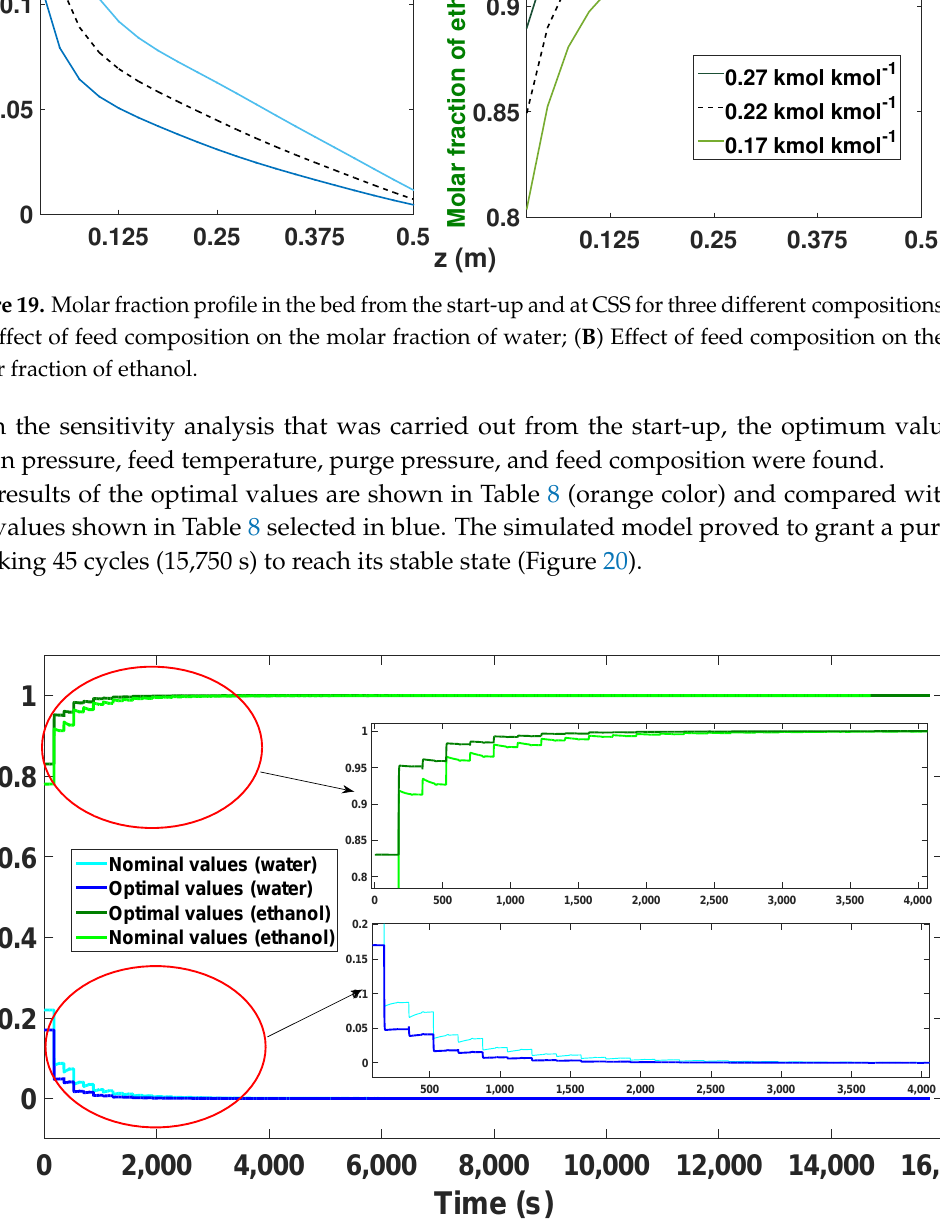
Figure 20. Comparison of the optimal results with the nominal values from the start-up to the CSS. Compared to the nominal values obtained, a better quality in the purity of ethanol was observed, taking only three more cycles than in the nominal